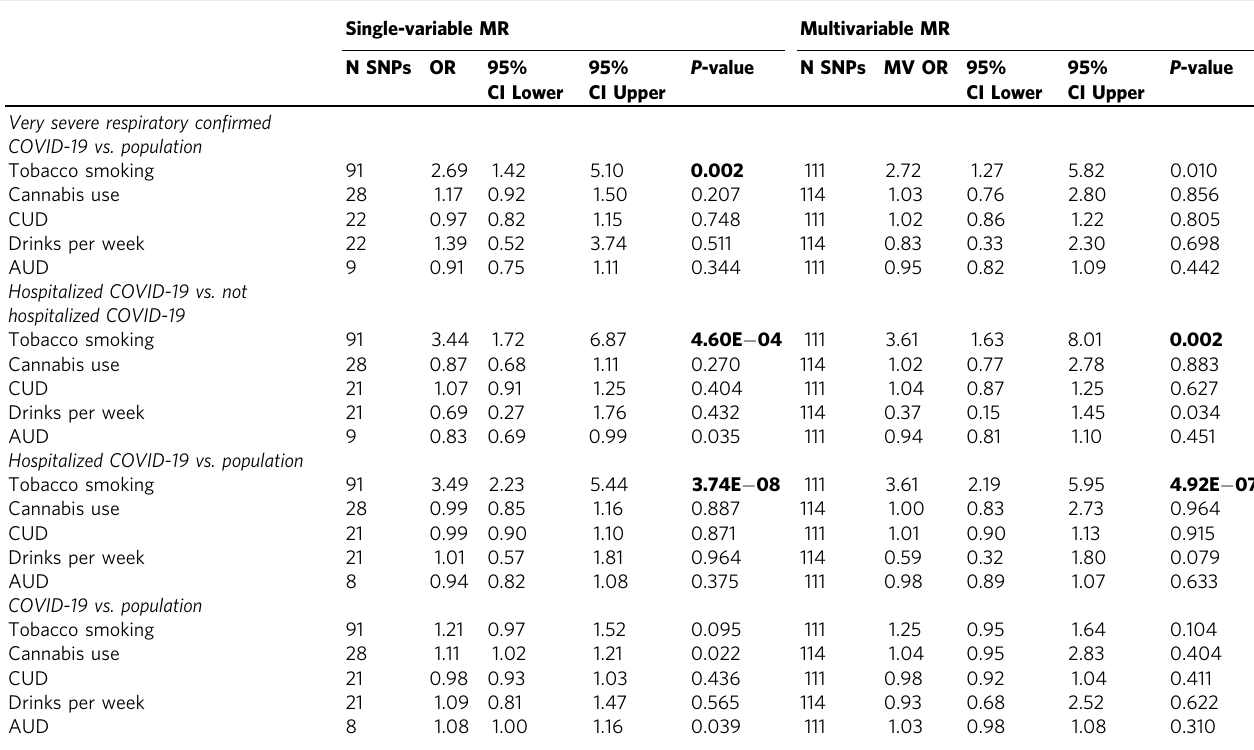
Table 1 Single variable and multivariable MR results of the genetic liability of alcohol, cannabis and lifetime smoking exposures on COVID-19